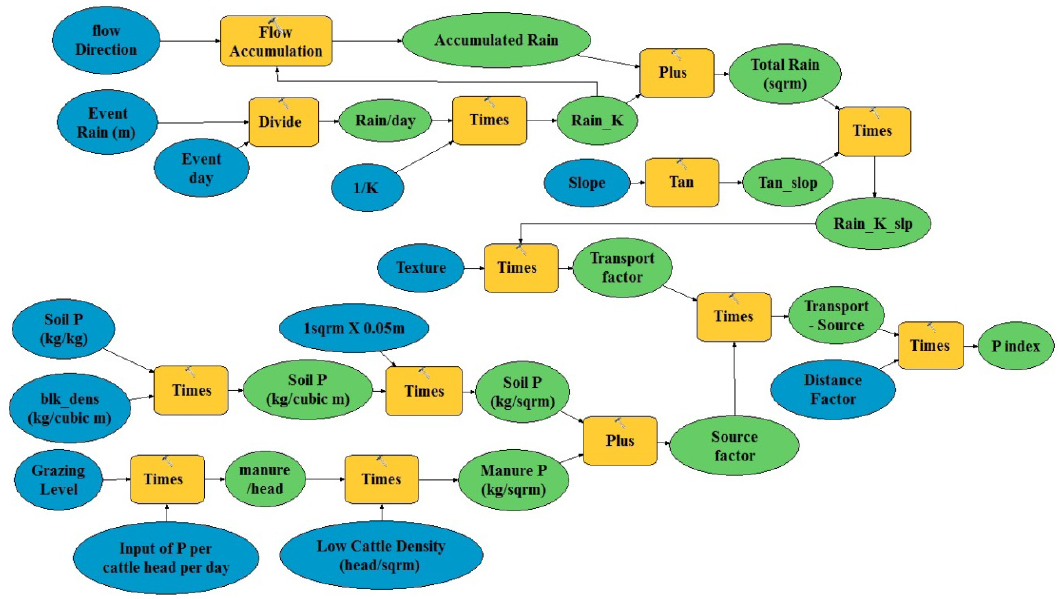
Figure 2. Flow diagram of P-index calculations using ArcView model